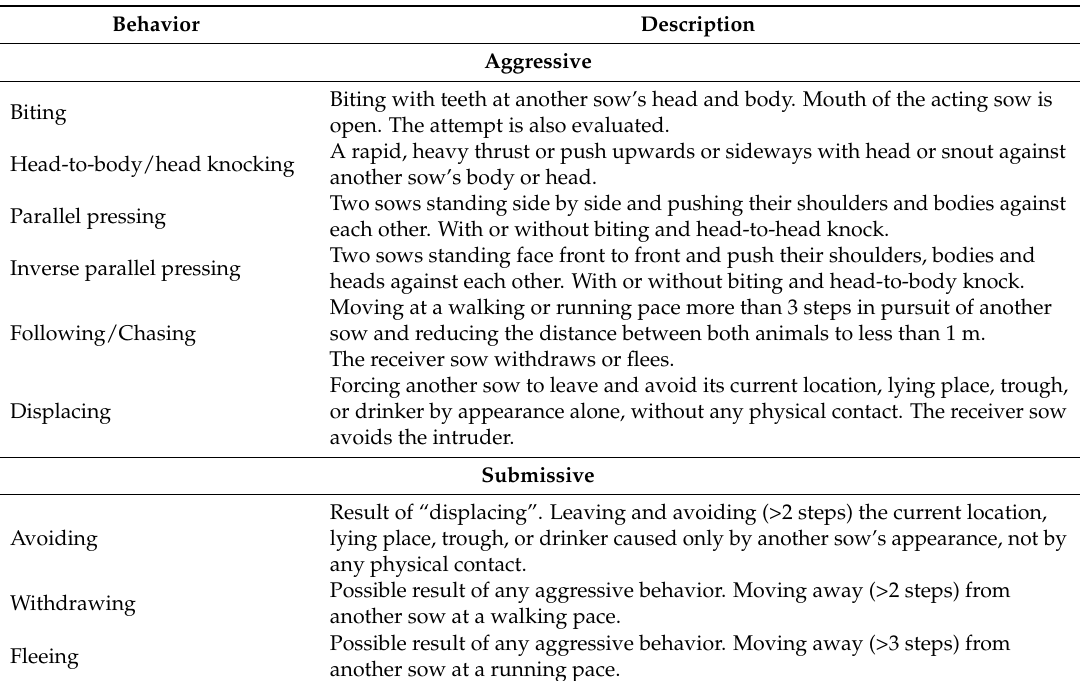
Table 1. Ethogram of aggressive and submissive behavior observed in pregnant sows. Behavior